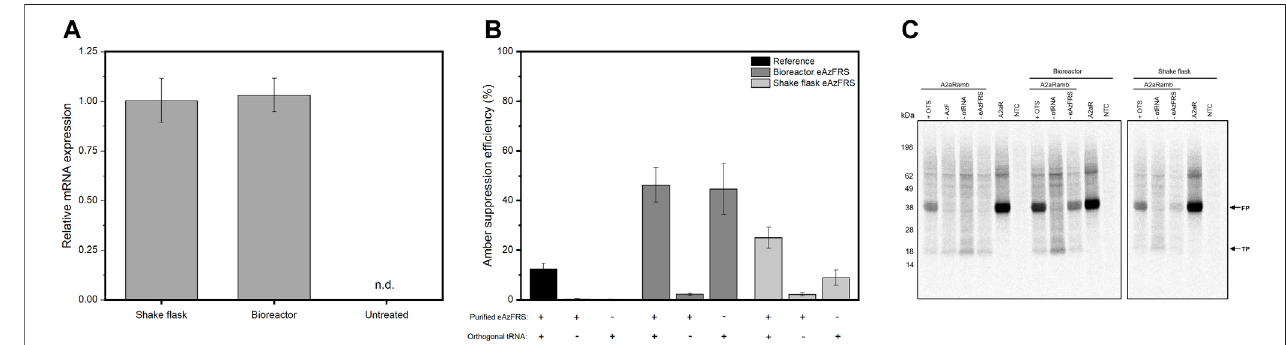
FIGURE 2 | CFPS based on transiently transfected CHO cells expressing eAzFRS. (A) Relative eAzFRS mRNA expression levels two days after transfection. Experiments were performed in technical triplicates and bars represent the standard deviation of the mean. (B) Amber suppression ef fi ciency based on cell-free synthesizedA2aRandA2aRambconstructsusingreferencecelllysatesandcelllysatesfromtransientlytransfectedCHOcells.Sampleswithaplusindicatetheaddition of either 4 µM puri fi ed eAzFRS and orthogonal tRNA, while a minus indicates the absence of the particular orthogonal component. Luminescence signals of cell- free reactions without a template (NTC) were subtracted from sample signals prior to calculation of suppression ef fi ciency. Data are shown as mean ± SEM ( n = 3). (C) Autoradiography of electrophoretically separated proteins based on a cell-free reaction with A2aR, A2aRamb constructs and a no-template control (NTC). n.d.: not detected, FP: Full-length protein, TP: Truncated protein, otRNA: Orthogonal tRNA, AzF: p-Azido-L-phenylalanine, OTS: Orthogonal translation system, TrCHO: Transiently transfected CHO